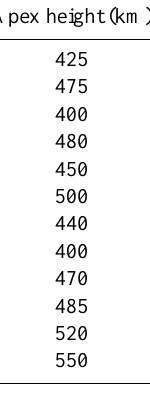
Table 1. Minimum and maximum values of the width and velocity of EPB depletions under quiet and disturbed magnetic conditions on the days for which, calculations were possible during 1998–2002.